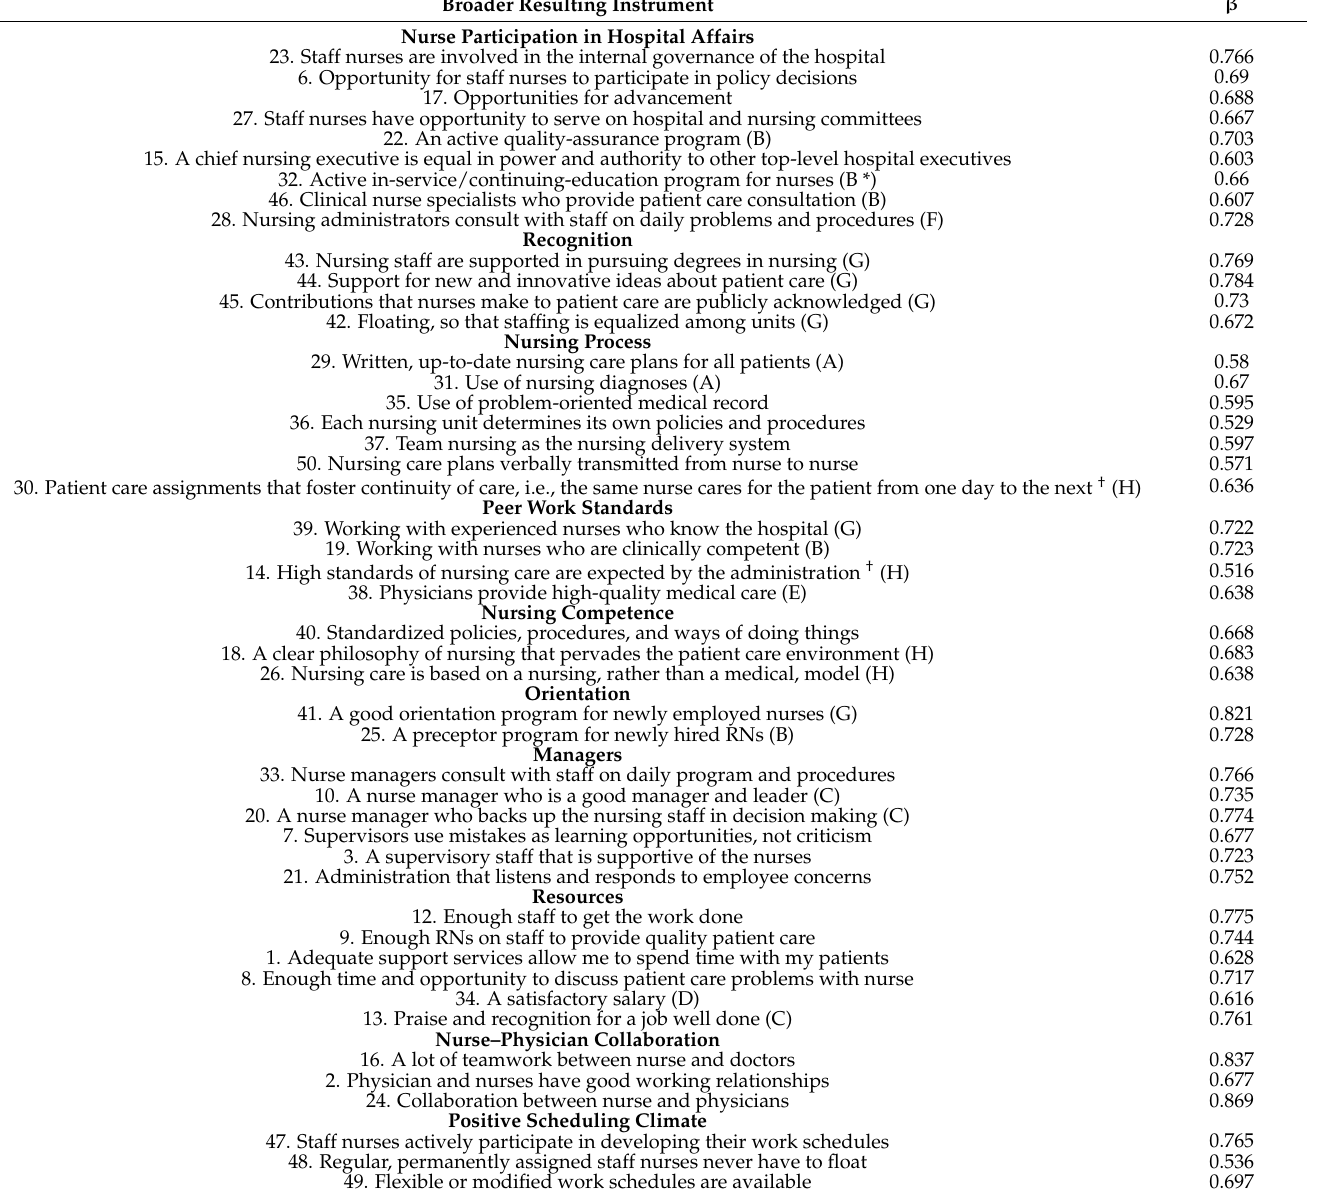
Table A2. The overall factor structures and loadings per relevant factor prior to removal of low- loading